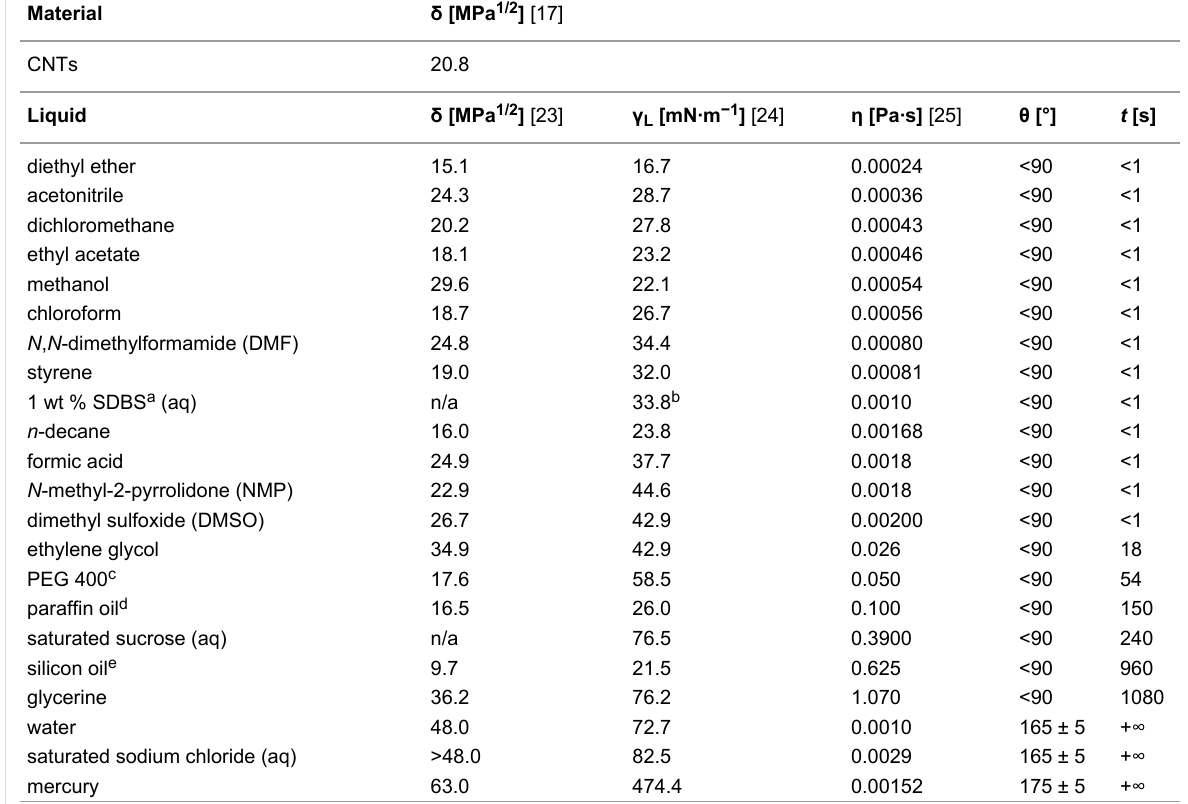
Table 1: Infiltration time ( t ) of the HACNT film with different liquids as a result of the combination of a thermodynamic prerequisite (the contact angle, θ ) and a kinetic stipulation (the viscosity, η ). γ L is the surface tension, and δ is the Hildebrand solubility parameter.